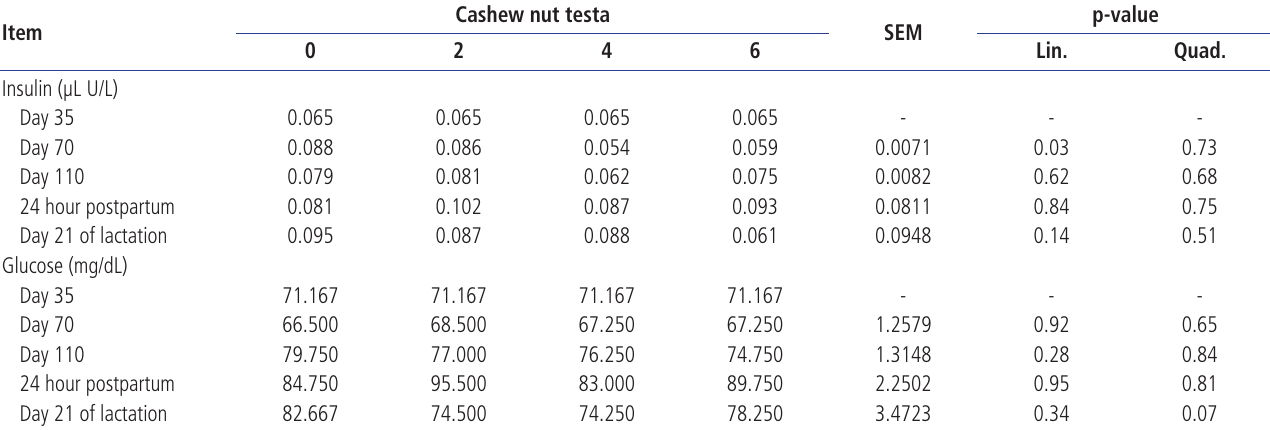
Table 8. Effect of cashew nut testa level on blood profiles of gestating and lactating sows